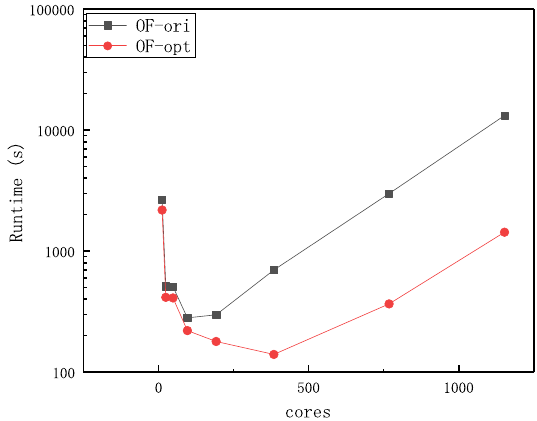
Figure 3. Strong Scaling Run Time in 3D damBreak.